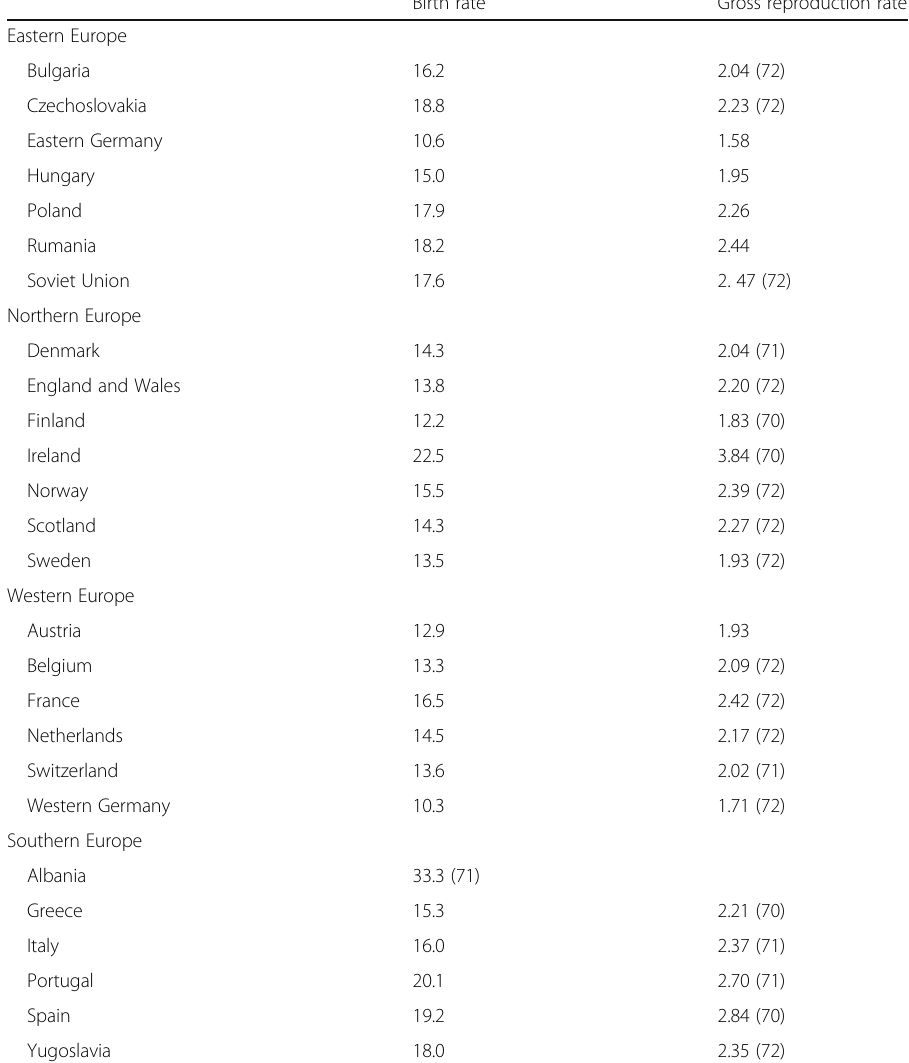
Table 1 Birth rate and gross reproduction rate in Europe, 1973